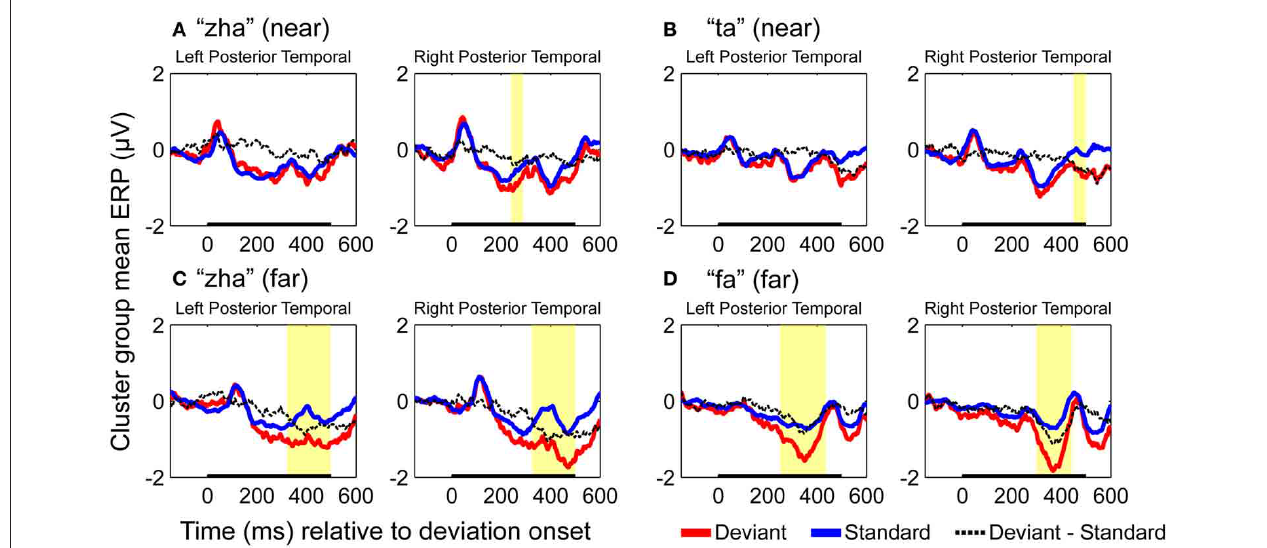
comparisons were performed over the times indicated by the heavy black line along the time axis. Highlighted regions denote statistically significant ( p < 0 . 05) differences of ERPs evoked by the stimulus as deviant vs. standard, corrected for multiple comparisons over time. Reliable differences were obtained for the right EOI means with all four syllable contrasts. Reliable differences were obtained for the left EOI means with only two far vMMN